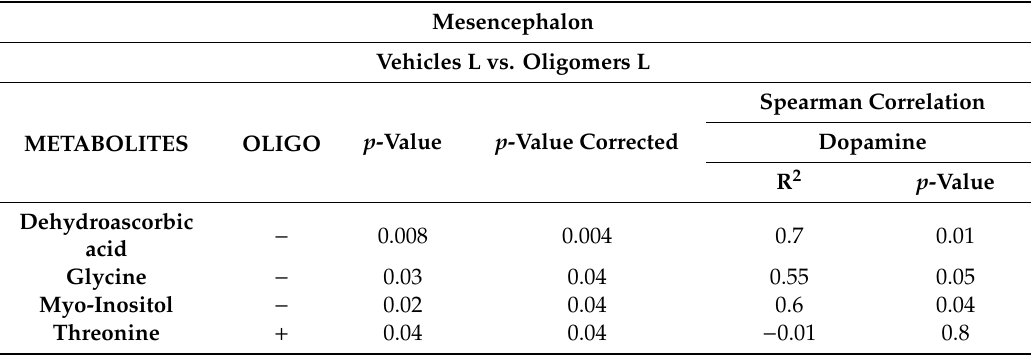
Table 2. Summary of the results of the univariate statistical analysis and Spearman correlation of the mesencephalon. Univariate statistical analysis and Spearman correlation of mesencephalic tissue from the left hemisphere of rats treated with Vehicle or H α SynOs + and − indicate respectively an increase or decrease of the metabolite in the OLIGO as compared with the Vehicle group.